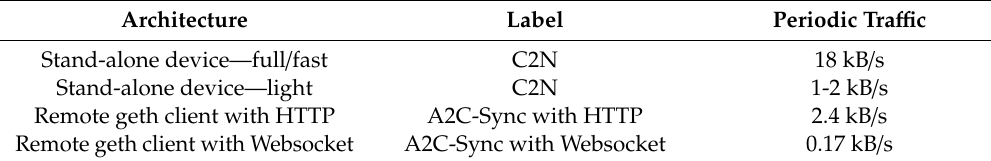
Table 4. Periodic communication tra ffi c between the device and the geth client.